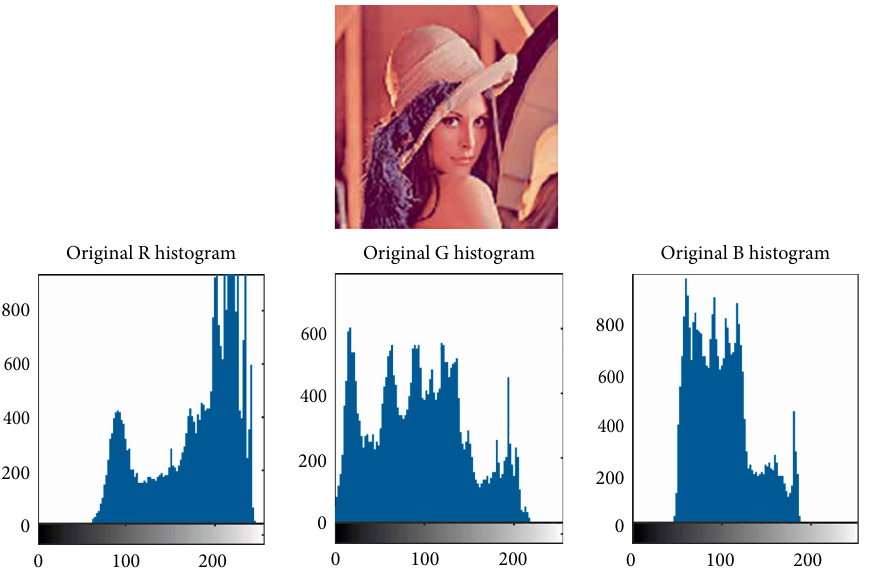
Figure 13: The original image with its histograms of color image (reproduced from Jing Luo et al. (2019), (under the Creative Commons Attribution License/public domain)).